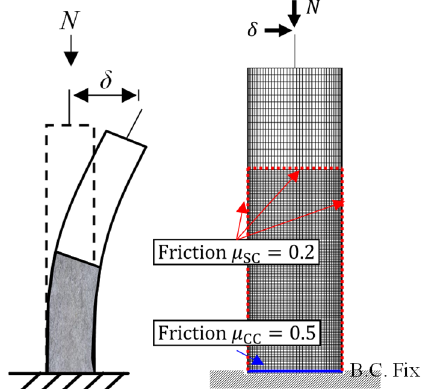
Figure 5. Numerical model boundary conditions.